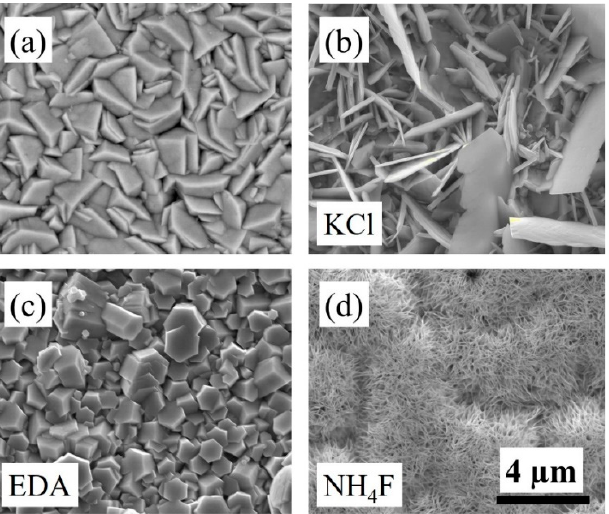
Figure 2. SEM images of electrodeposited ( a ) ZnO, ( b ) ZnO + KCl, ( c ) ZnO + EDA, and ( d ) ZnO + NH ₄ F. All images have the same scale bar.